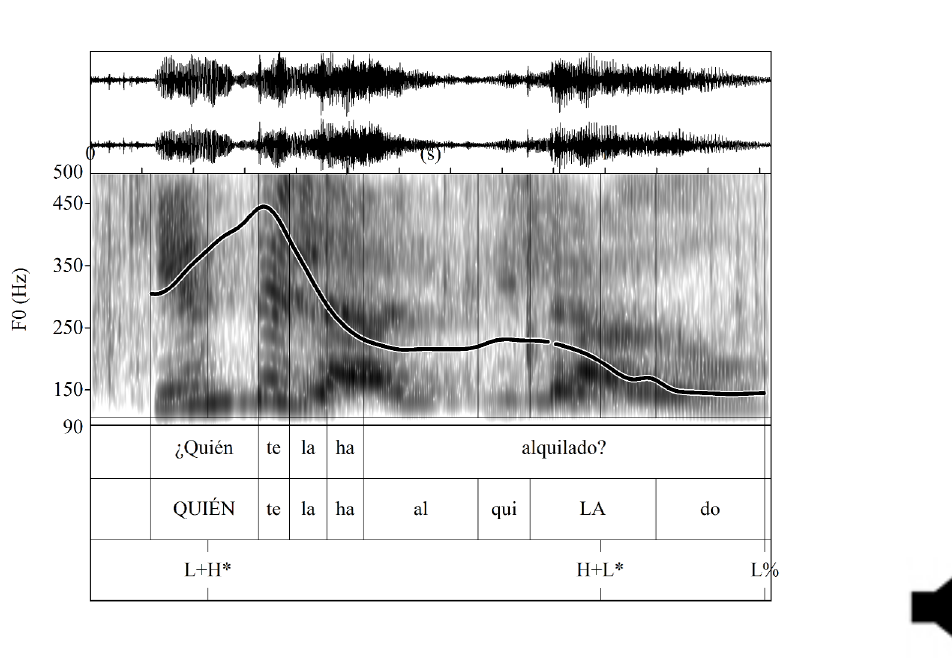
Figure 19 (Participant 31): Waveform and F0 trace for the neutral wh- question ¿Quién te la ha alquilado? ‘Who has rented you the house?’ produced as L+H* (in prenuclear position) and as and H+L* L% (nuclear configuration)